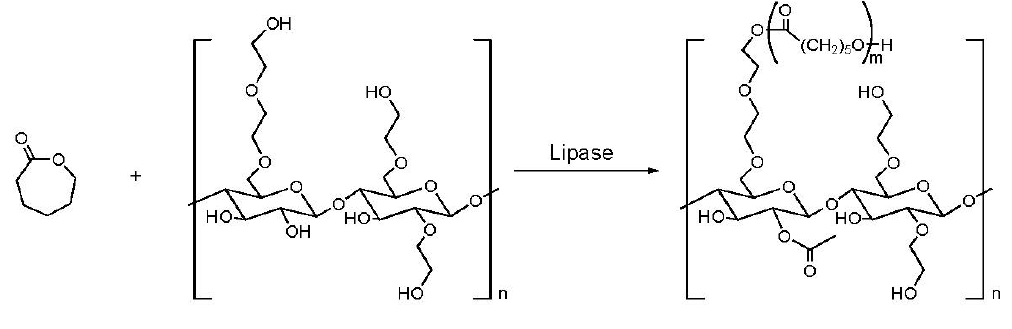
Figure 2. Lipase-catalyzed graft copolymerization of ε